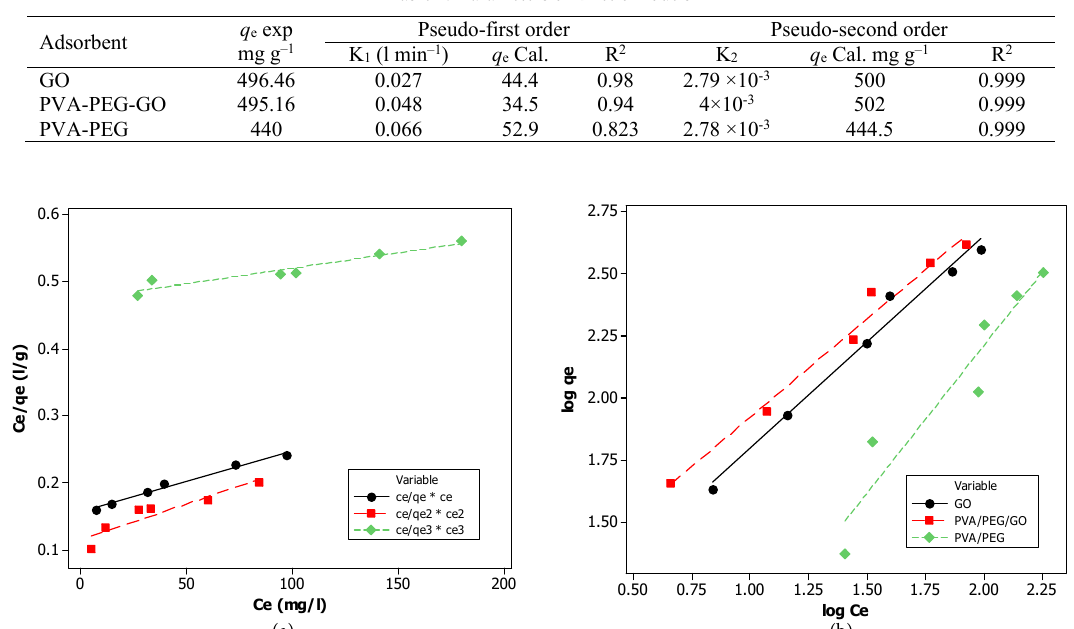
Fig. 10: (a) Langmuir and (b) Freundlich adsorption isotherm models of Cu (II) on GO, PVA-PEG-GO, and